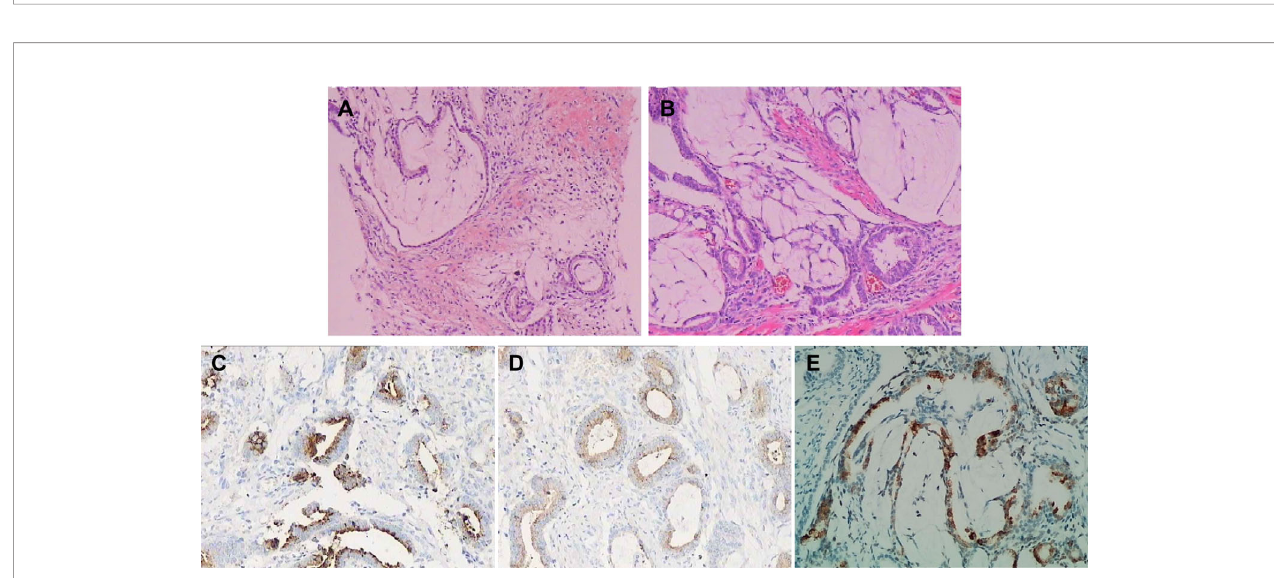
FIGURE 3 | Histopathological and immunohistochemical fi ndings of the tumor. (A) Hematoxylin and Eosin stained section of needle biopsy found prostate tissue with interstitial edema around the acinar, part of which showed mucus edema-like changes. (B) Hematoxylin and Eosin stained section of TUPKP specimen manifested multifocal mucinous adenocarcinoma with diffuse in fi ltration. GS was 4 + 3 = 7. Immunohistochemical staining showed positive for PSA (C) and PSAP (D) , and MUC2 staining showed ∼ 20% positivity (E) .